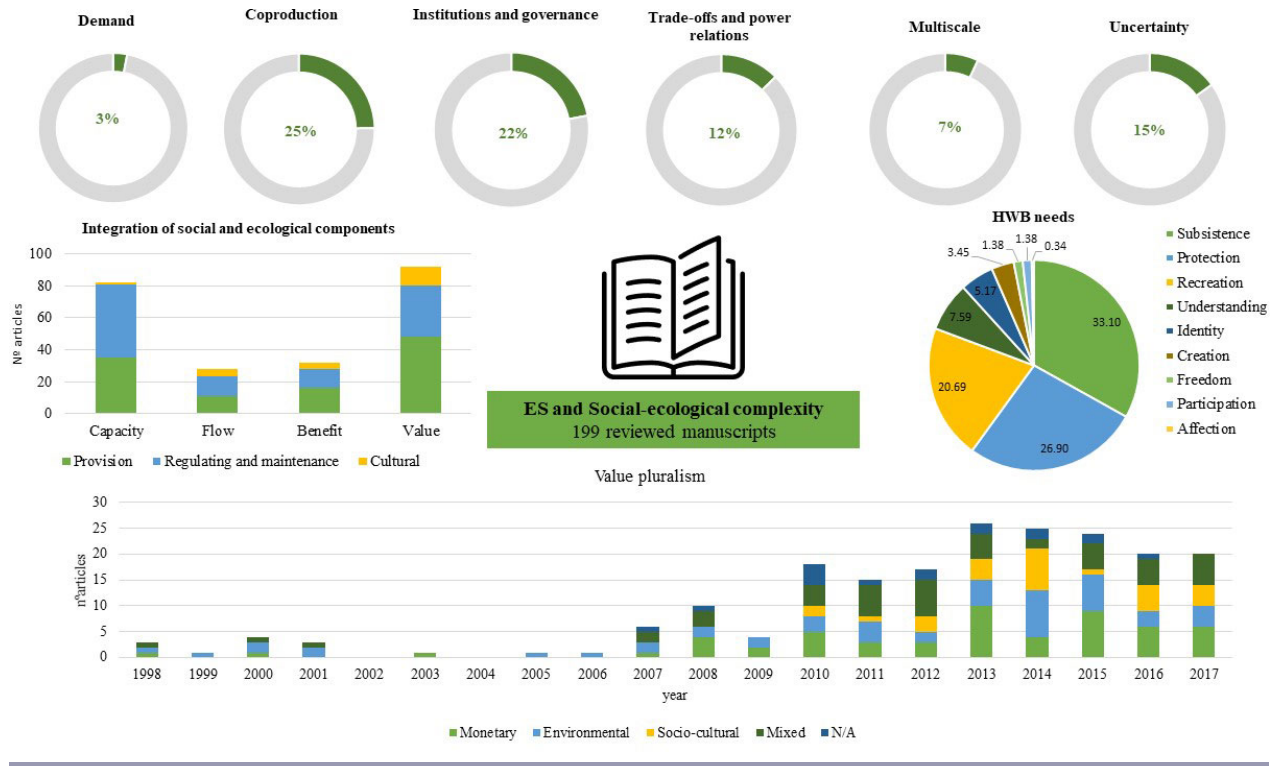
Fig. 2 . The results of this systematic review are presented in this infographic figure. The top part of the figure presents the percentage of articles assessing demand, coproduction processes, institutions and governance, trade-offs and power, multiscale (temporal and spatial) processes, and uncertainty. The central-right pie graph represents the number of manuscripts that address each human well-being (HWB) axiological need defined by Max-Neef et al. (1998): subsistence, protection, recreation, understanding, identity, creation, freedom, participation, and affection. On the other side of the figure (central left-side), the column graph represents how many articles address each of the cascade-model components (capacity, flow, benefit, and value) by ecosystem services (ES) general categories (provision, regulating and maintenance, and cultural). Finally, the graph located on the lower part of the figure shows the number of articles and type of assessed values per year, from 1998 to